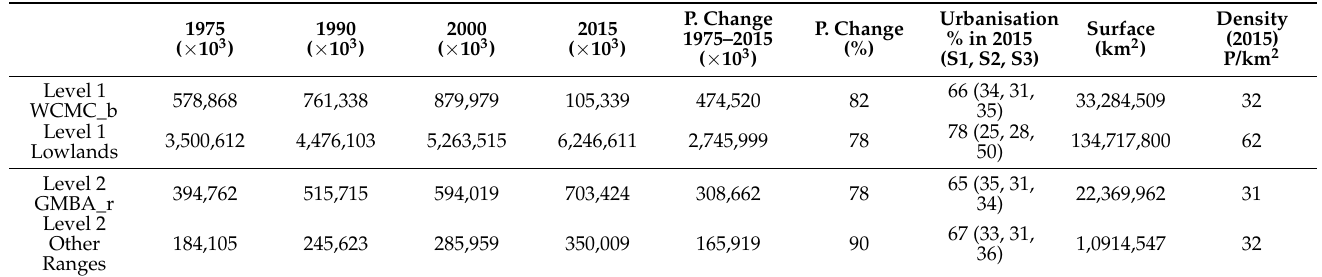
Table 1. Population in four epochs, population trends, urbanisation in 2015 including a breakdown for Rural areas (S1), Towns (S2) and Cities (S3), and Surface and density for the two Earth land masses subsets: the lowlands and the WCMC (Level 1); and for the two WCMC subsets, GMBA_r and Other Ranges (Level